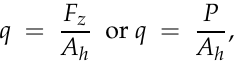
Figure 11. The ice bending model illustration: a semi-infinite plate resting on an elastic foundation and subjected to a uniform distributed load.